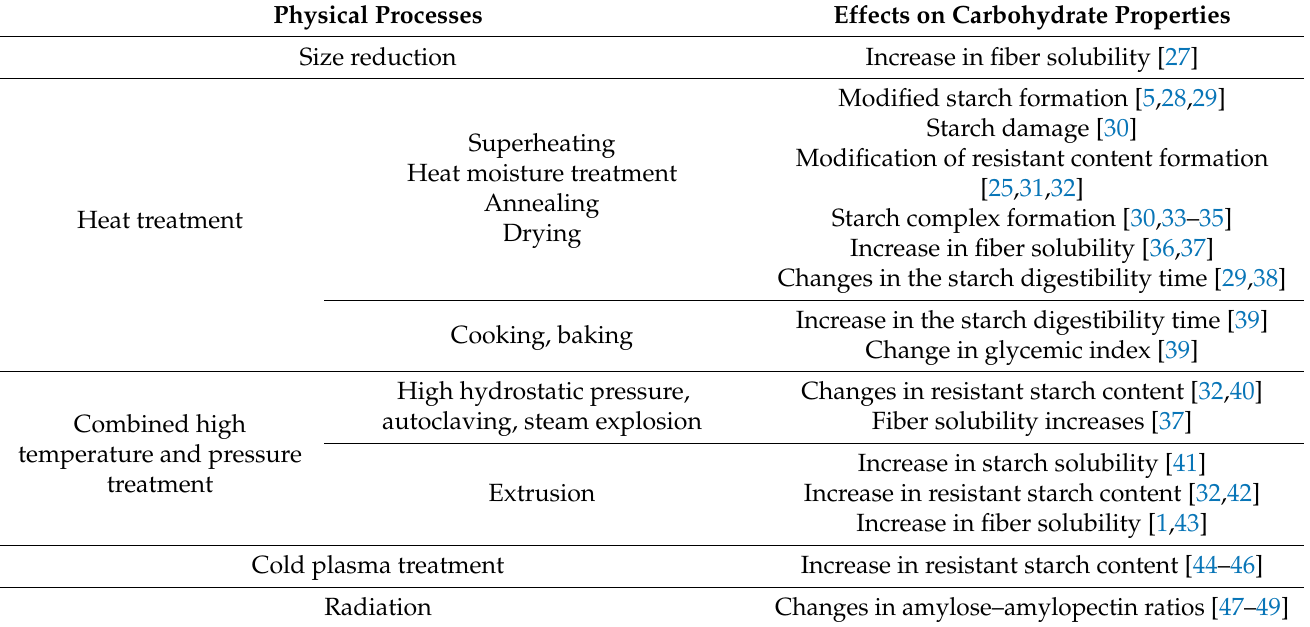
Table 1. Physical processing-induced nutritional modifications of